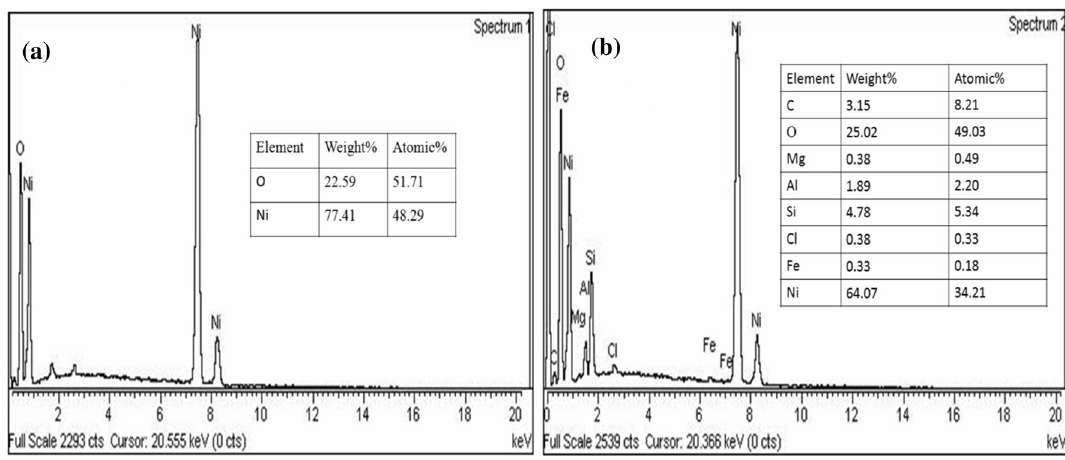
Fig. 2 EDX spectra of a NiO NPs b NiO/Nc